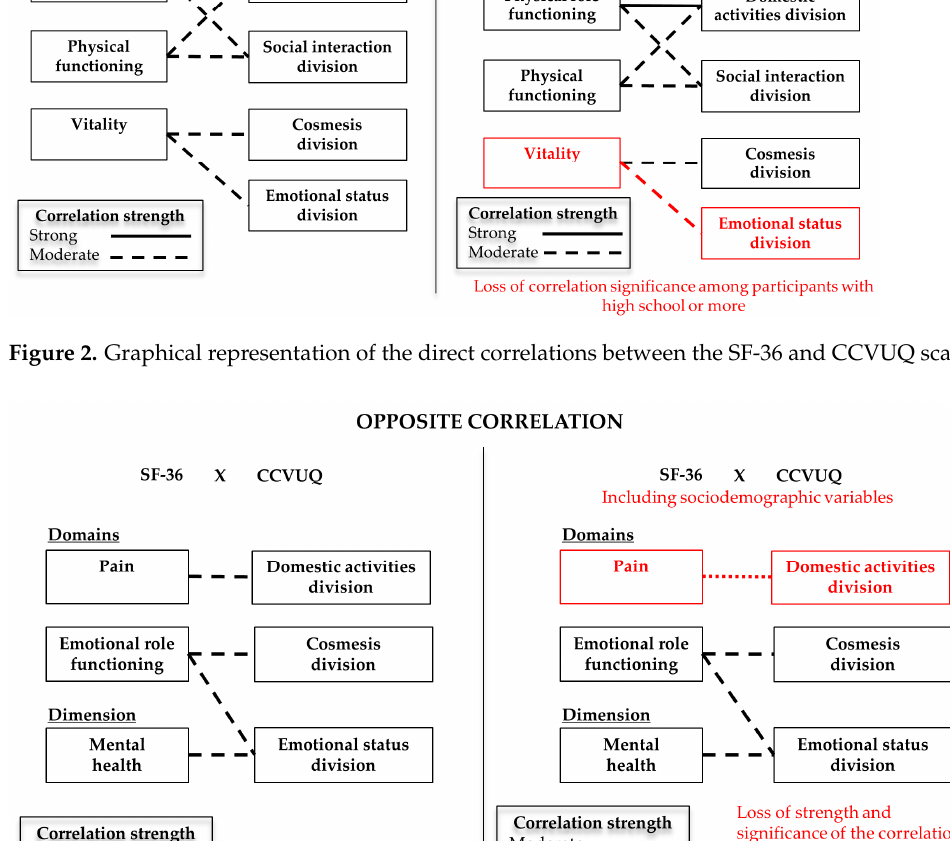
Figure 3. Graphical representation of the opposite correlations between the SF-36 and CCVUQ scales.